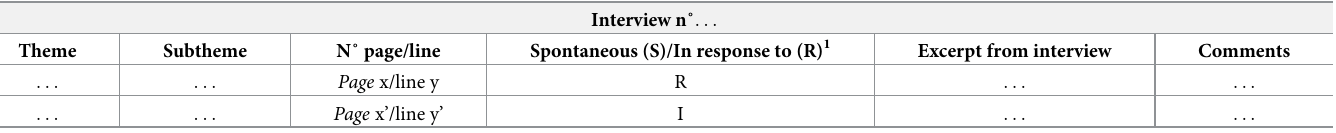
Table 1. Vertical analysis (by interview).